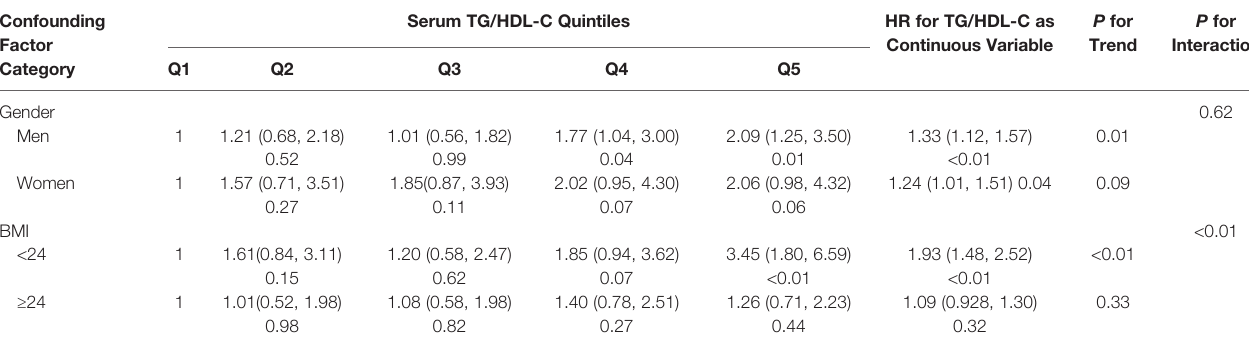
TABLE 4 | Subgroup